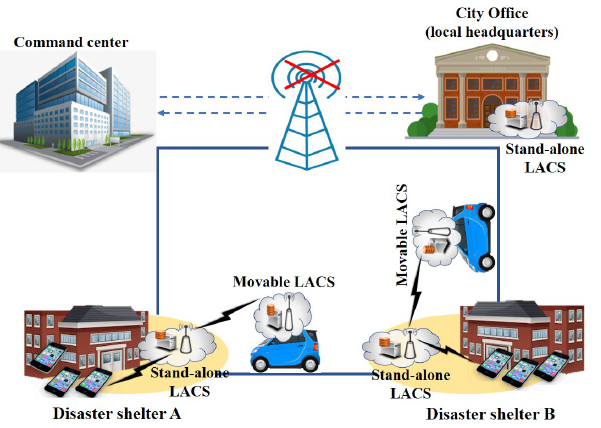
Figure 5. Information delivery/collecting between standalone LACS deployed to a disaster shelter and movable